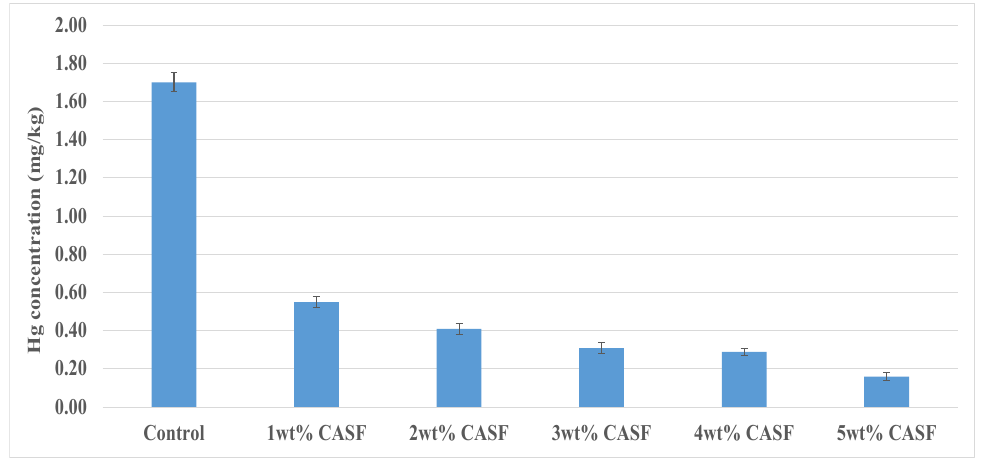
Figure 7. Hg leachability of the control and CASF (-#10 mesh) treated samples after 28d of curing, upon 1N HCl extraction.